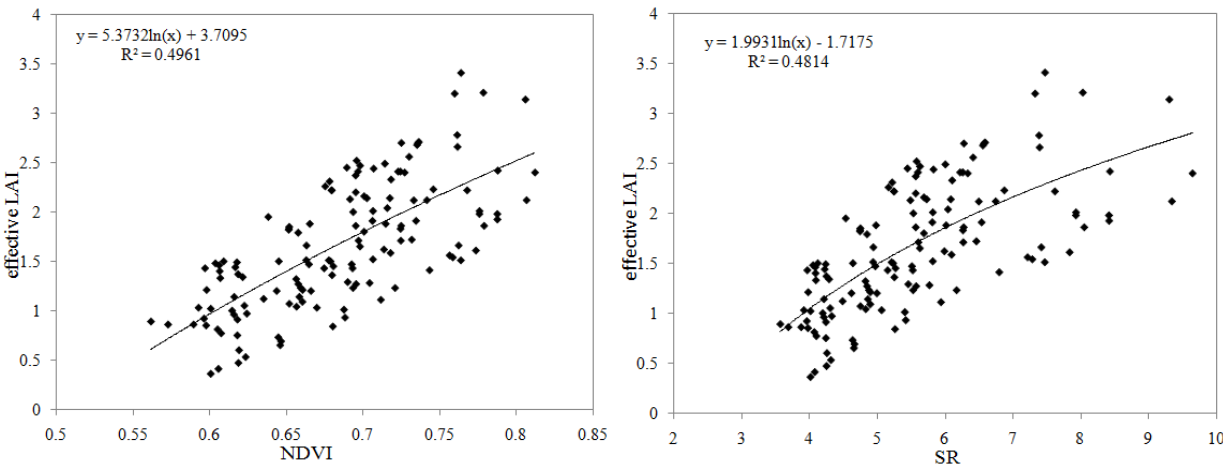
Figure 4. Relationships between in situ LAI-NDVI ( left ) and LAI-SR ( right ).